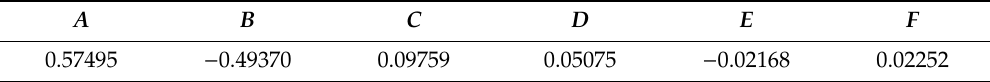
Table 4. Optimal value of constant coe ffi cients for h sp /